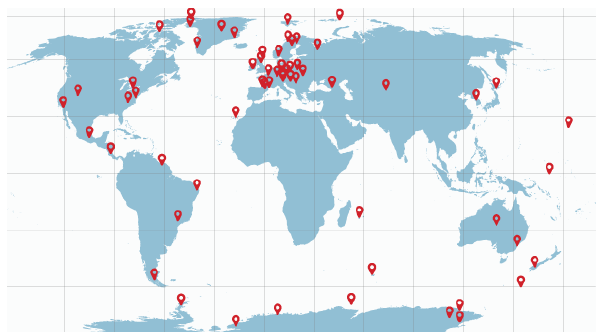
Figure 2. Map of currently active NDACC